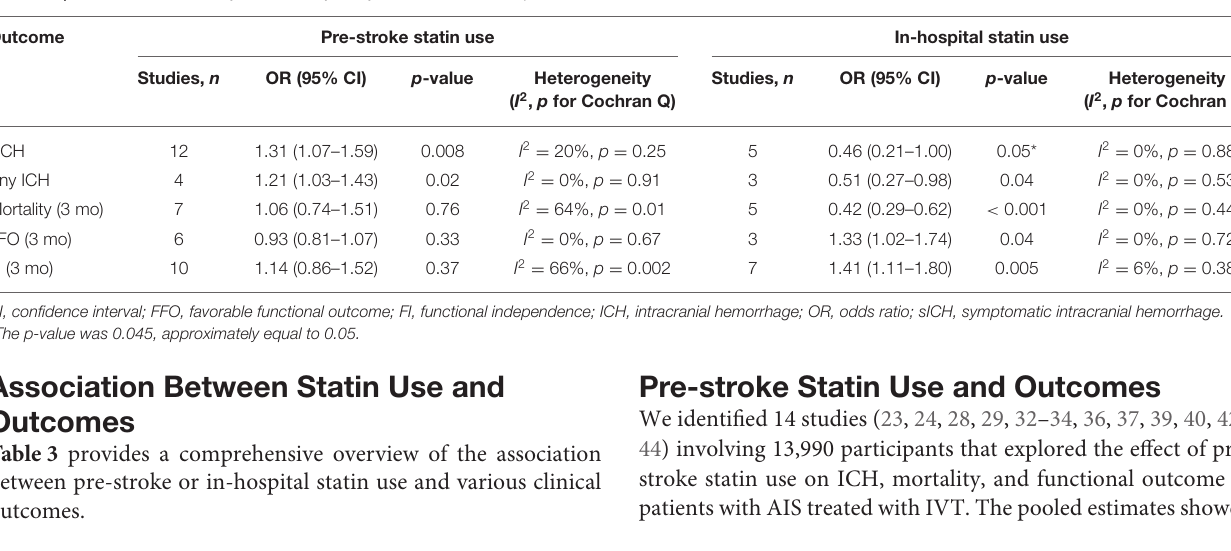
TABLE 3 | Overview of the safety and efficacy analyses on different